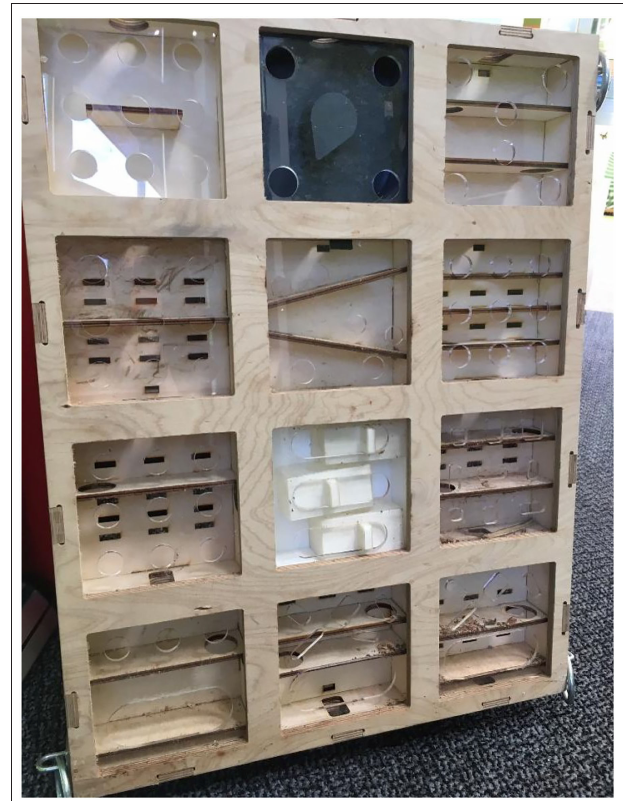
FIGURE 1 | Gorilla Game Lab cognitive enrichment device. A 3D finger maze consisting of 12 puzzle modules. The modular design allows a camera to be fitted inside or on top of the modules. In turn, this allows footage of the gorilla engaging with the device to be